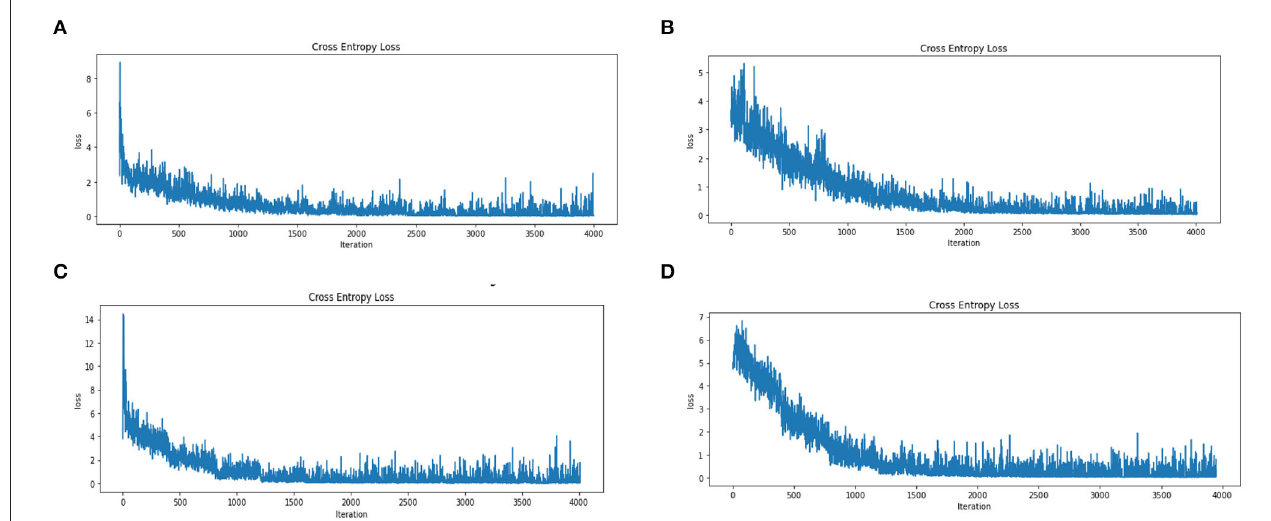
FIGURE 5 | Error Loss for Training on A Dataset Based on CNN Model on the Four States of the Augmented Dataset (A) . Dataset on Year (B) . On ± 6-Month (C) . On ± 3 Month and (D) . On ± 1 Month. (A) Error loss for dataset years. (B) Error loss for the dataset with ± 6 months. (C) Error loss for the dataset with ± 3 months. (D) Error loss for the dataset with ± 1